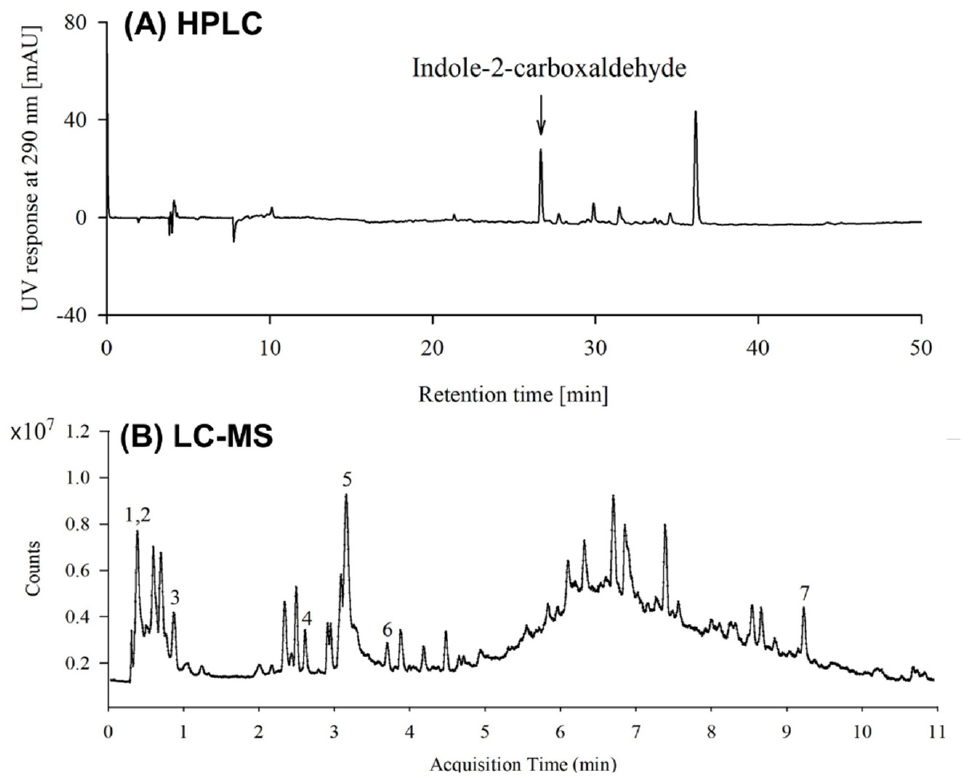
Figure 1. Representative ( A ) HPLC (290 nm) and ( B ) LC-MS chromatogram of S . thunbergii extract. 1. L-rhamnulose, 2. Dulcitol, 3. p-Coumaric acid, 4. Indole-2-carboxaldehyde, 5. Isovalerycanitine, 6. Loliolide, and 7. Cinnamic acid. Table 3. Chemical characterization of S. thunbergii extract by LC-MS.